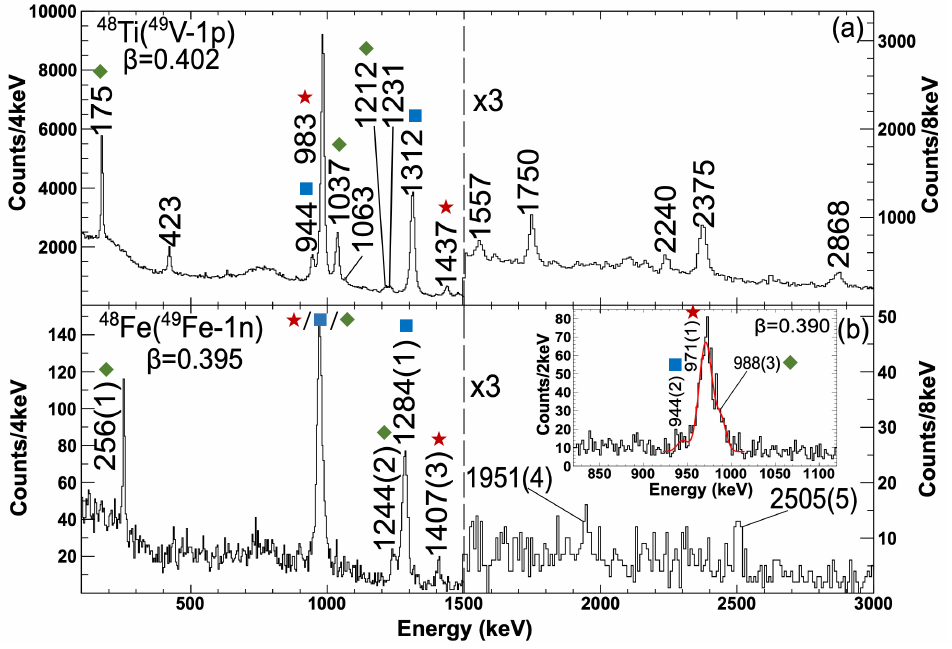
Figure 3. The γ -ray spectra observed in the case study [8]. The spectra are measured with the GRETINA array following the identification and selection of the relevant incoming and outgoing fragment beams. Panel ( a ) shows the 49 V − 1 p → 48 Ti reaction and ( b ) the mirrored 49 Fe − 1 n → 48 Fe reaction. The peaks are labelled by the γ -ray energy and the symbols refer to the angular momen- tum/parity, J π , of the states from which these decays proceed. Decays from the 2 + states are labelled 1,2 with blue squares, the 4 + states with green diamonds and the 6 + states with red stars. The insert in 1,2 1,2 ( b ) shows how the peak around 970 keV comprises three γ rays. Adapted from